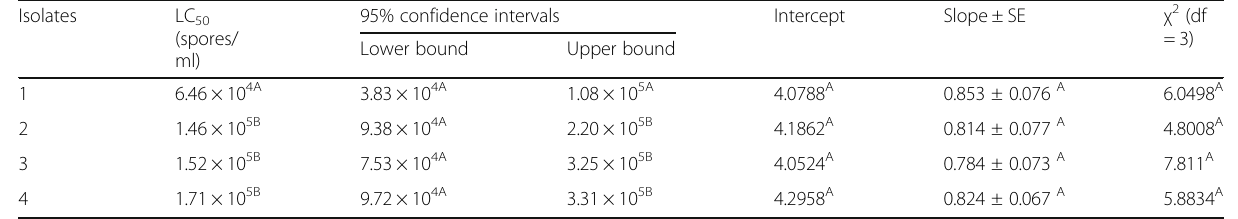
Table 1 Values of LC 50 with 95% confidence intervals of the four tested indigenous isolates of Beauveria bassiana on rose aphid, Macrosiphum